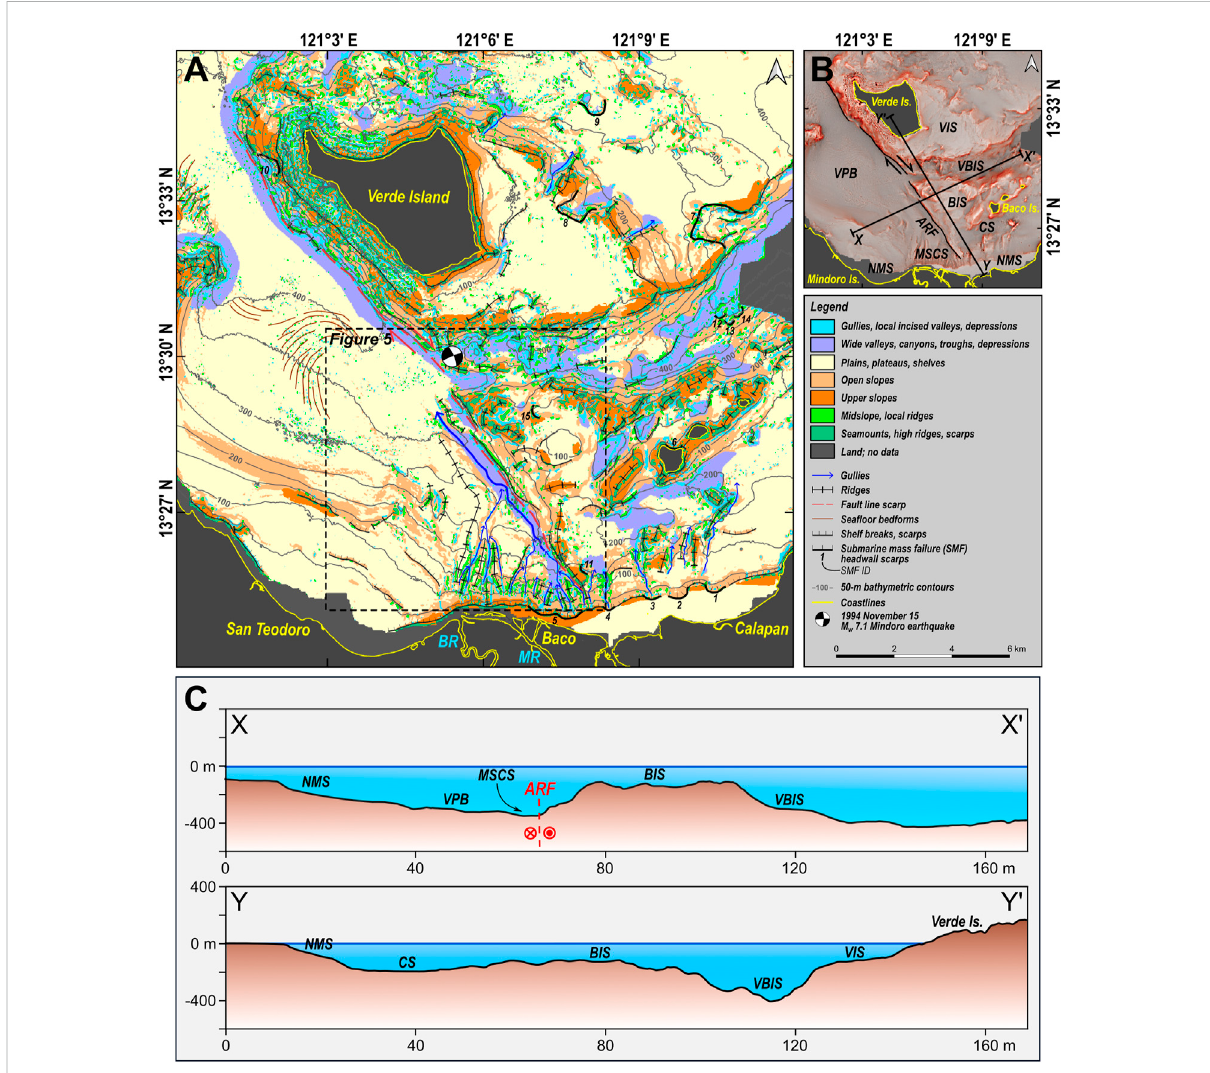
FIGURE 4 Submarine geomorphology of the South Pass, Verde Island Passage. (A) Map of submarine landforms and features. The headwall scarps of the 15mappedprobableSMFs(Table4)arealsolabeled.Theextentofthe3DrenderinginFigure5isalsoshown. (B) ReliefmapoftheSouthPass,labeled with identi fi edmain submarine features andtransectsfor thebathymetricpro fi lesshown in (C). ARF= AglubangRiverFault;BIS =Baco Islands Shelf; CS = Calapan Saddle; MSCS = Malaylay Submarine Canyon System; NMS = Northern Mindoro Shelf; VBIS = Verde-Baco Islands Saddle; VIS = Verde Island Shelf; VPB = Verde Passage Basin; BR = Baco River; MR = Malaylay